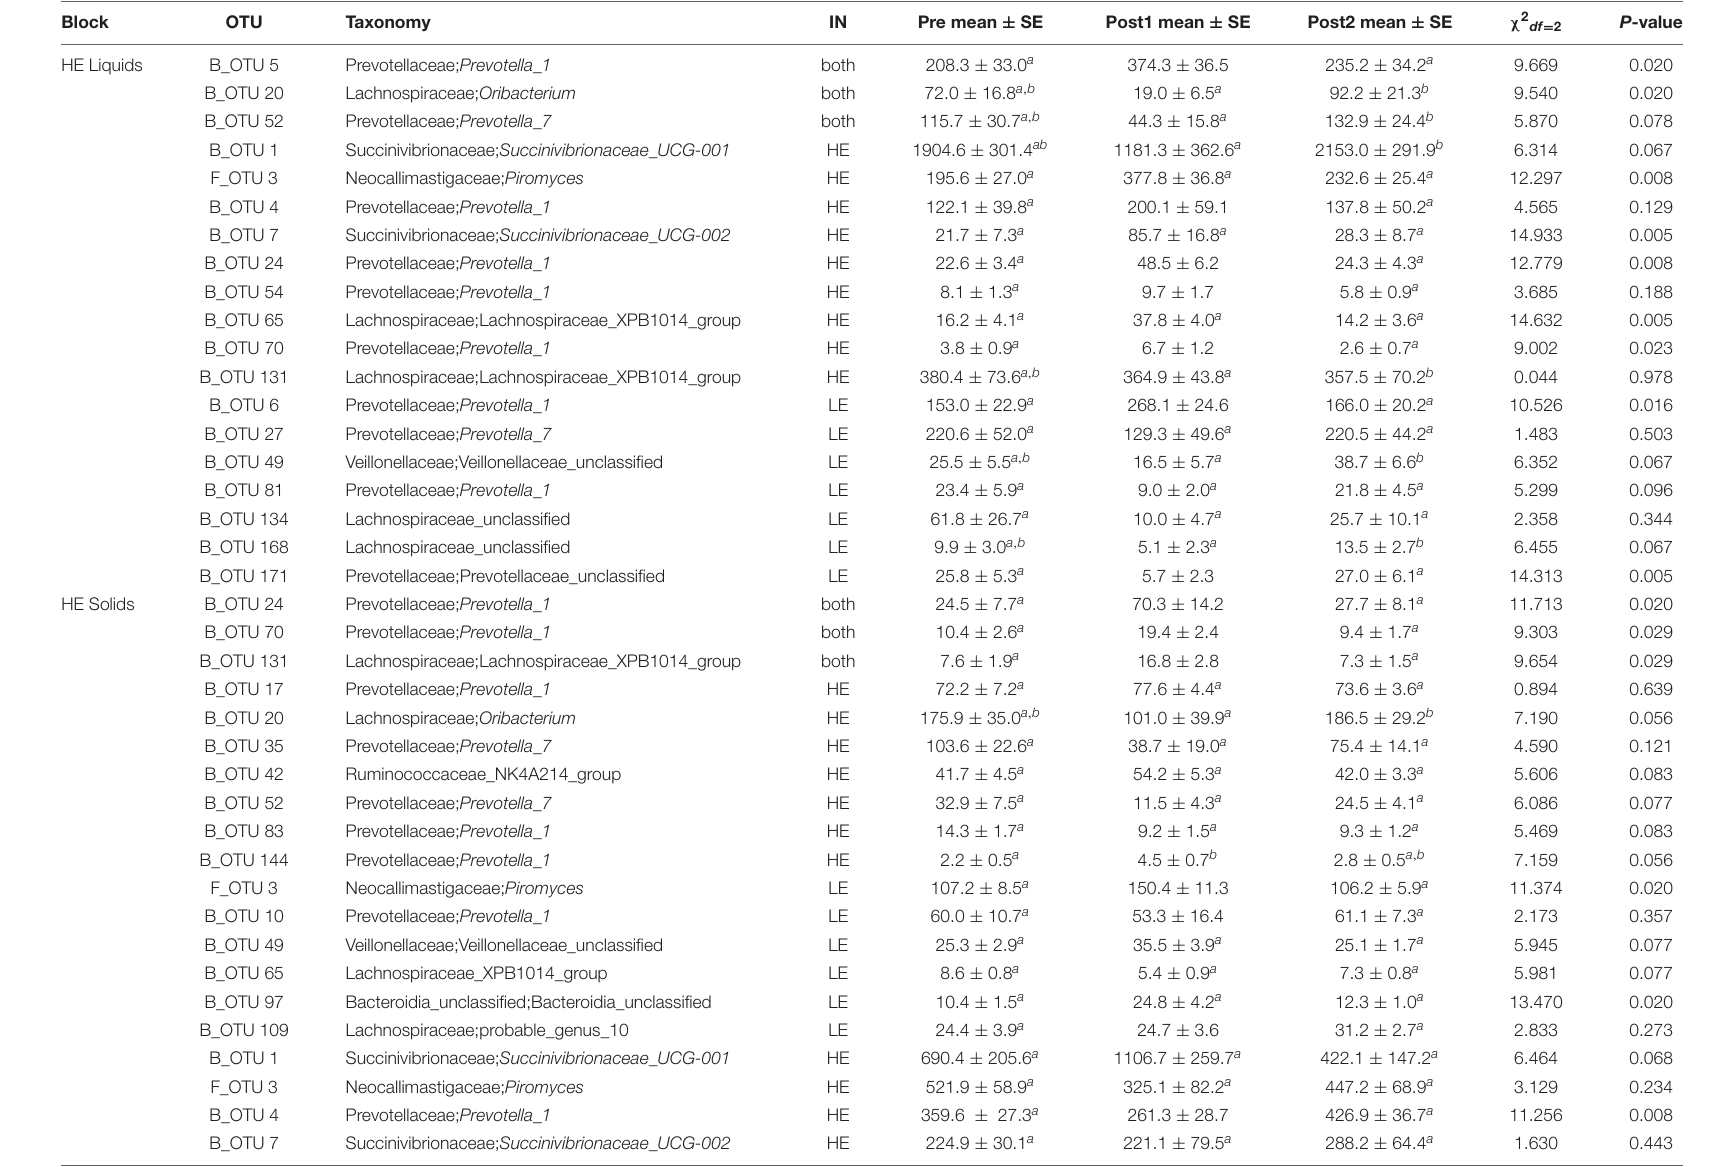
TABLE 1 | Kruskal-Wallis tests of influential OTUs in Pre-exchange